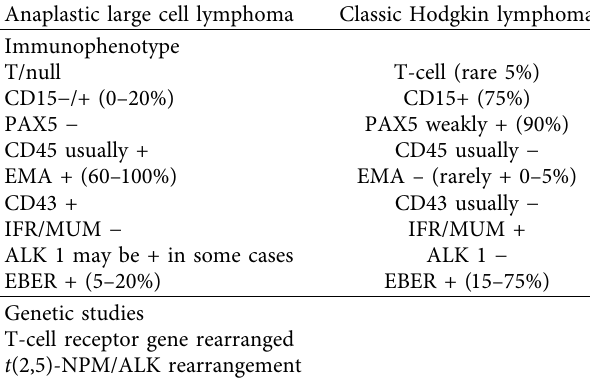
Table 1: Immunophenotypic and genetic studies. Anaplastic large cell lymphoma Classic Hodgkin lymphoma